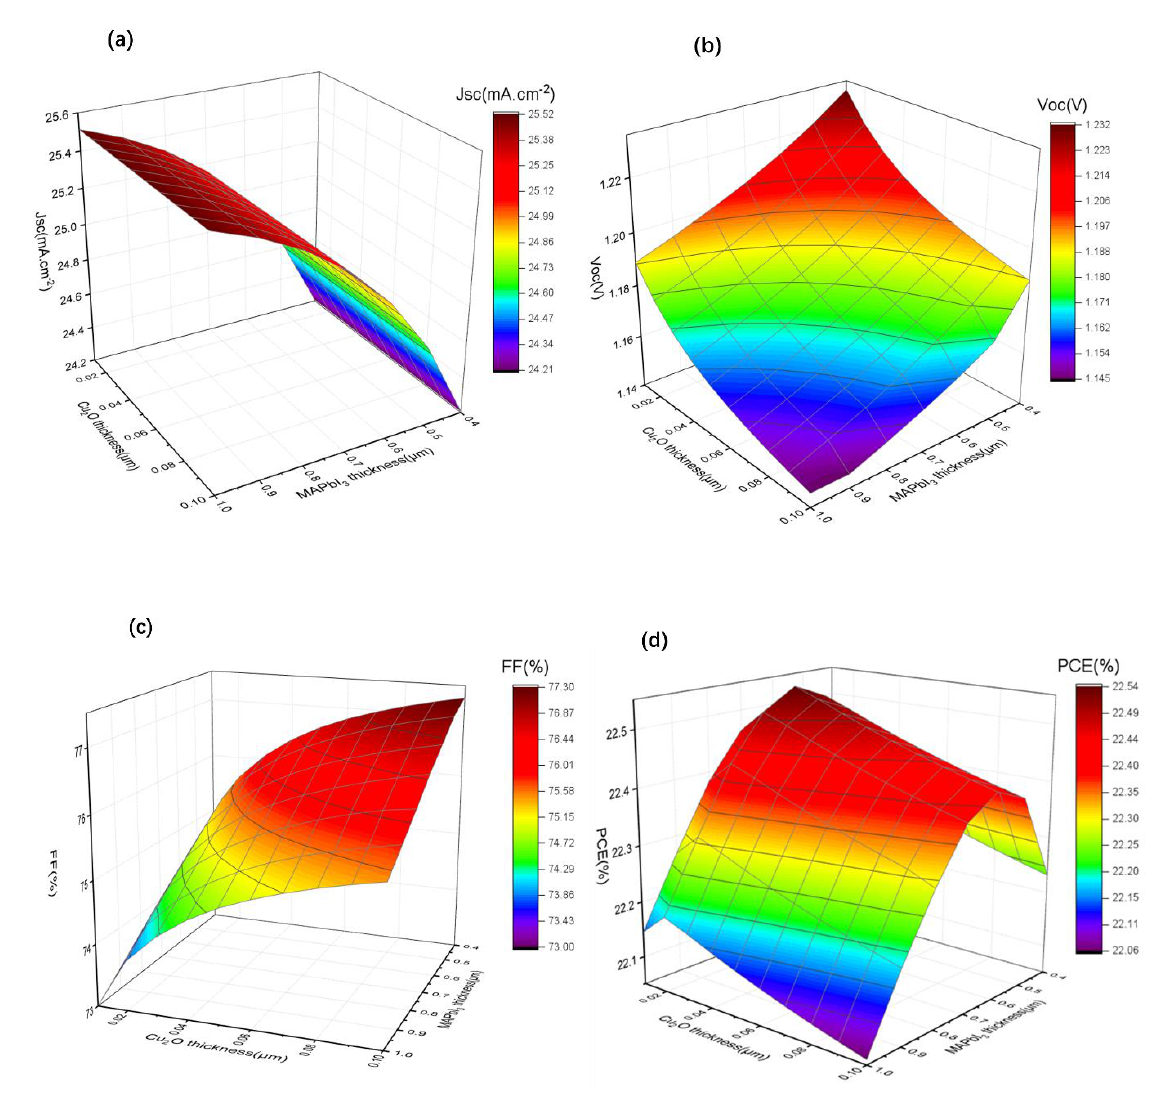
Figure 6. ( a – d ) The variation of J sc , V oc , FF , and PCE with different perovskite layer (0.4 µ m to 1 µ m) and Cu 2 O buffer layer (0.01 µ m to 0.1 µ m) thicknesses.